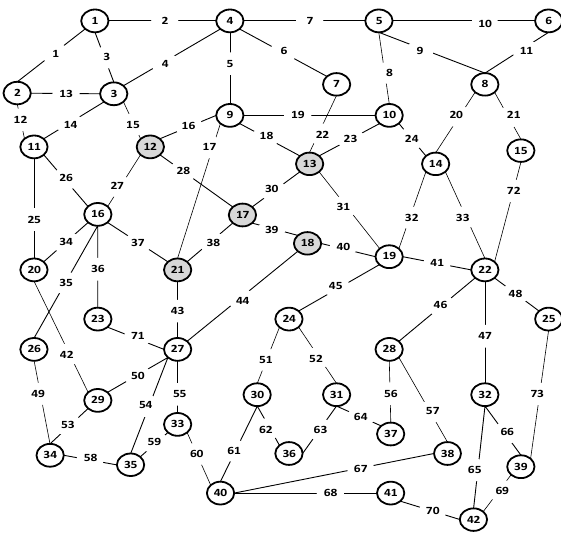
Figure 6. Graph with a highlighted cluster at the 1 st